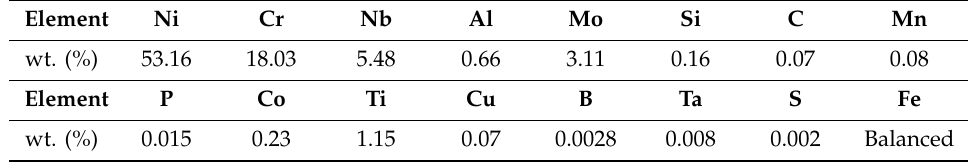
Table 1. The chemical components of IN718 alloy.